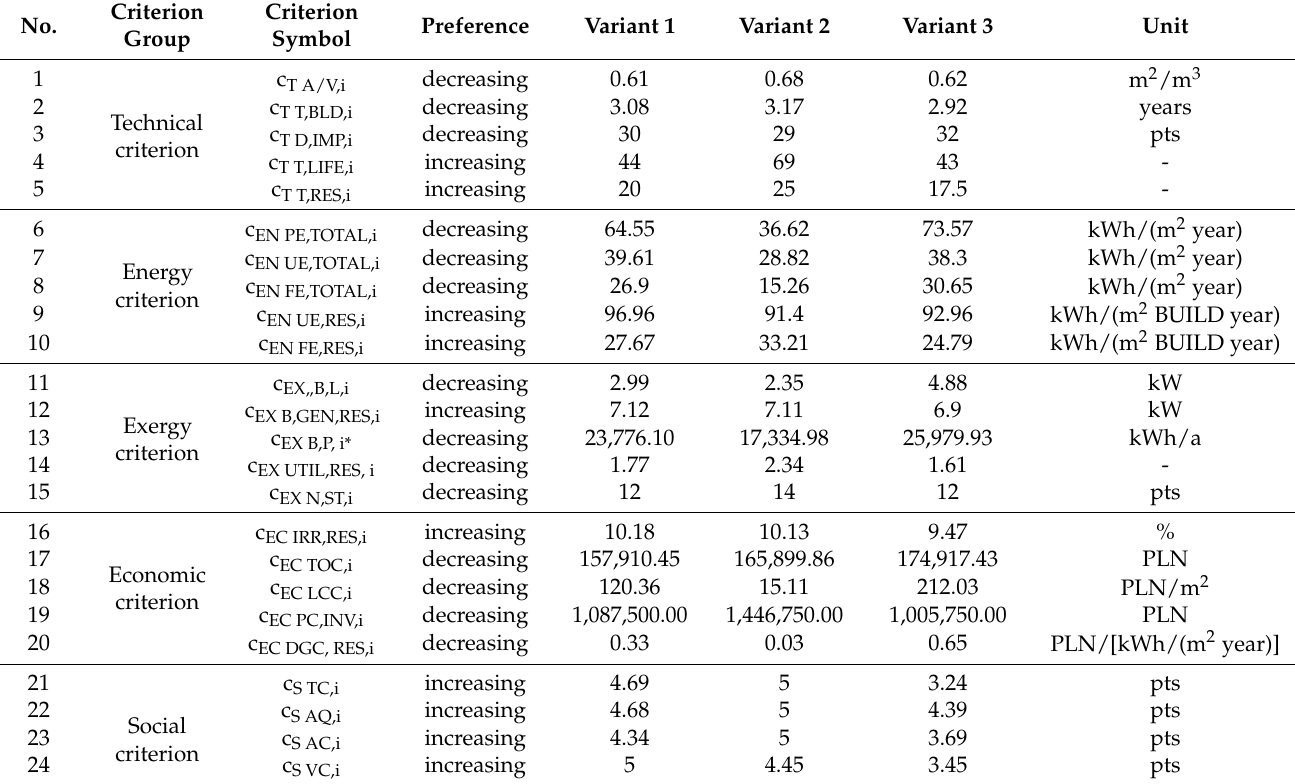
Table 7. Numerical values of indicators and their preferences for selected sub-criteria of